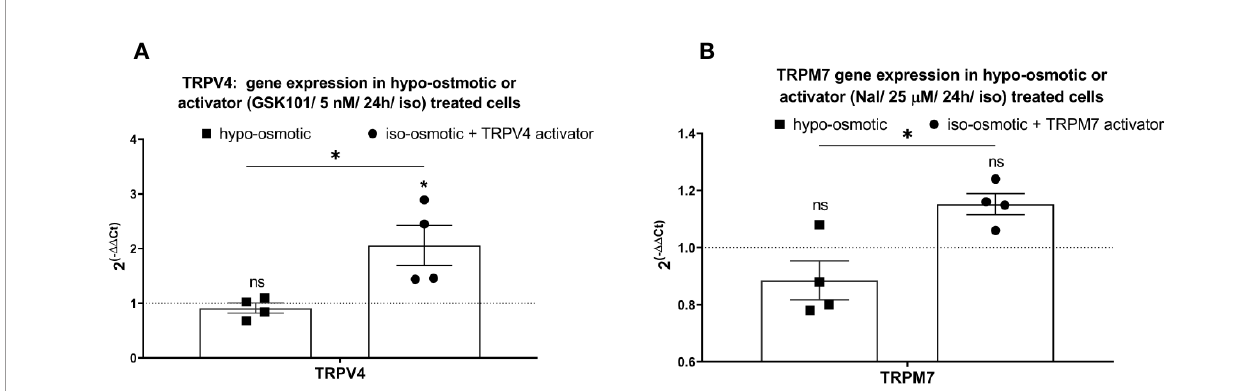
FIGURE 6 | The mRNA expression of (A) TRPV4 in NP cells treated with 5 nM GSK1016790A, and (B) TRPM7 in NP cells treated with 25 µM Naltriben after 24 h. Graphs show 2 − DD Ct normalized to the iso-osmotic control (mean ± SEM, bNP P2, n = 4). Asterisks indicate statistical signi fi cance (*p < 0.05, no statistical difference de fi ned at p > 0.05) between hypo-osmotic group, iso-osmotic group or iso-osmotic activator-supplemented